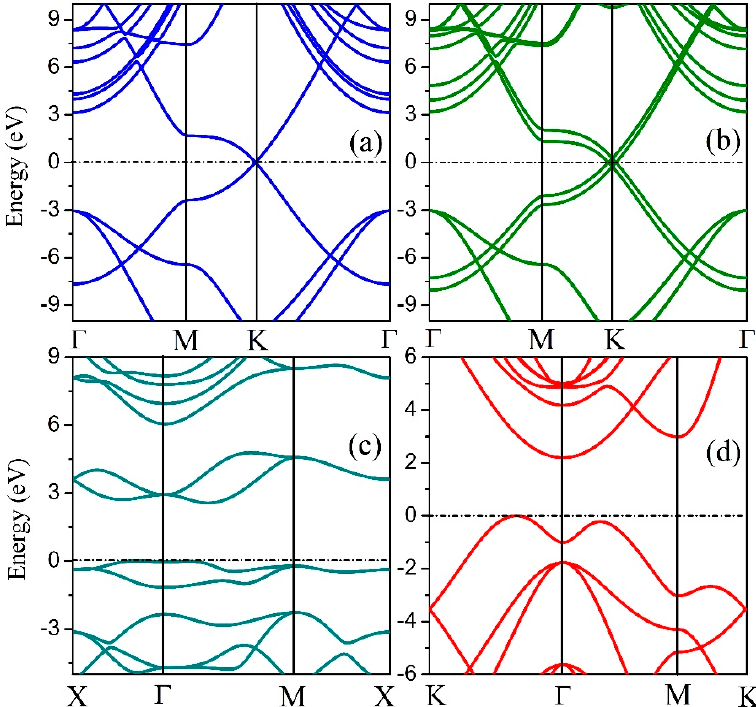
Figure 4. Band structures of ( a ) graphene, ( b ) bilayer graphene, ( c ) penta-graphene, and ( d ) hexatetra-carbon.